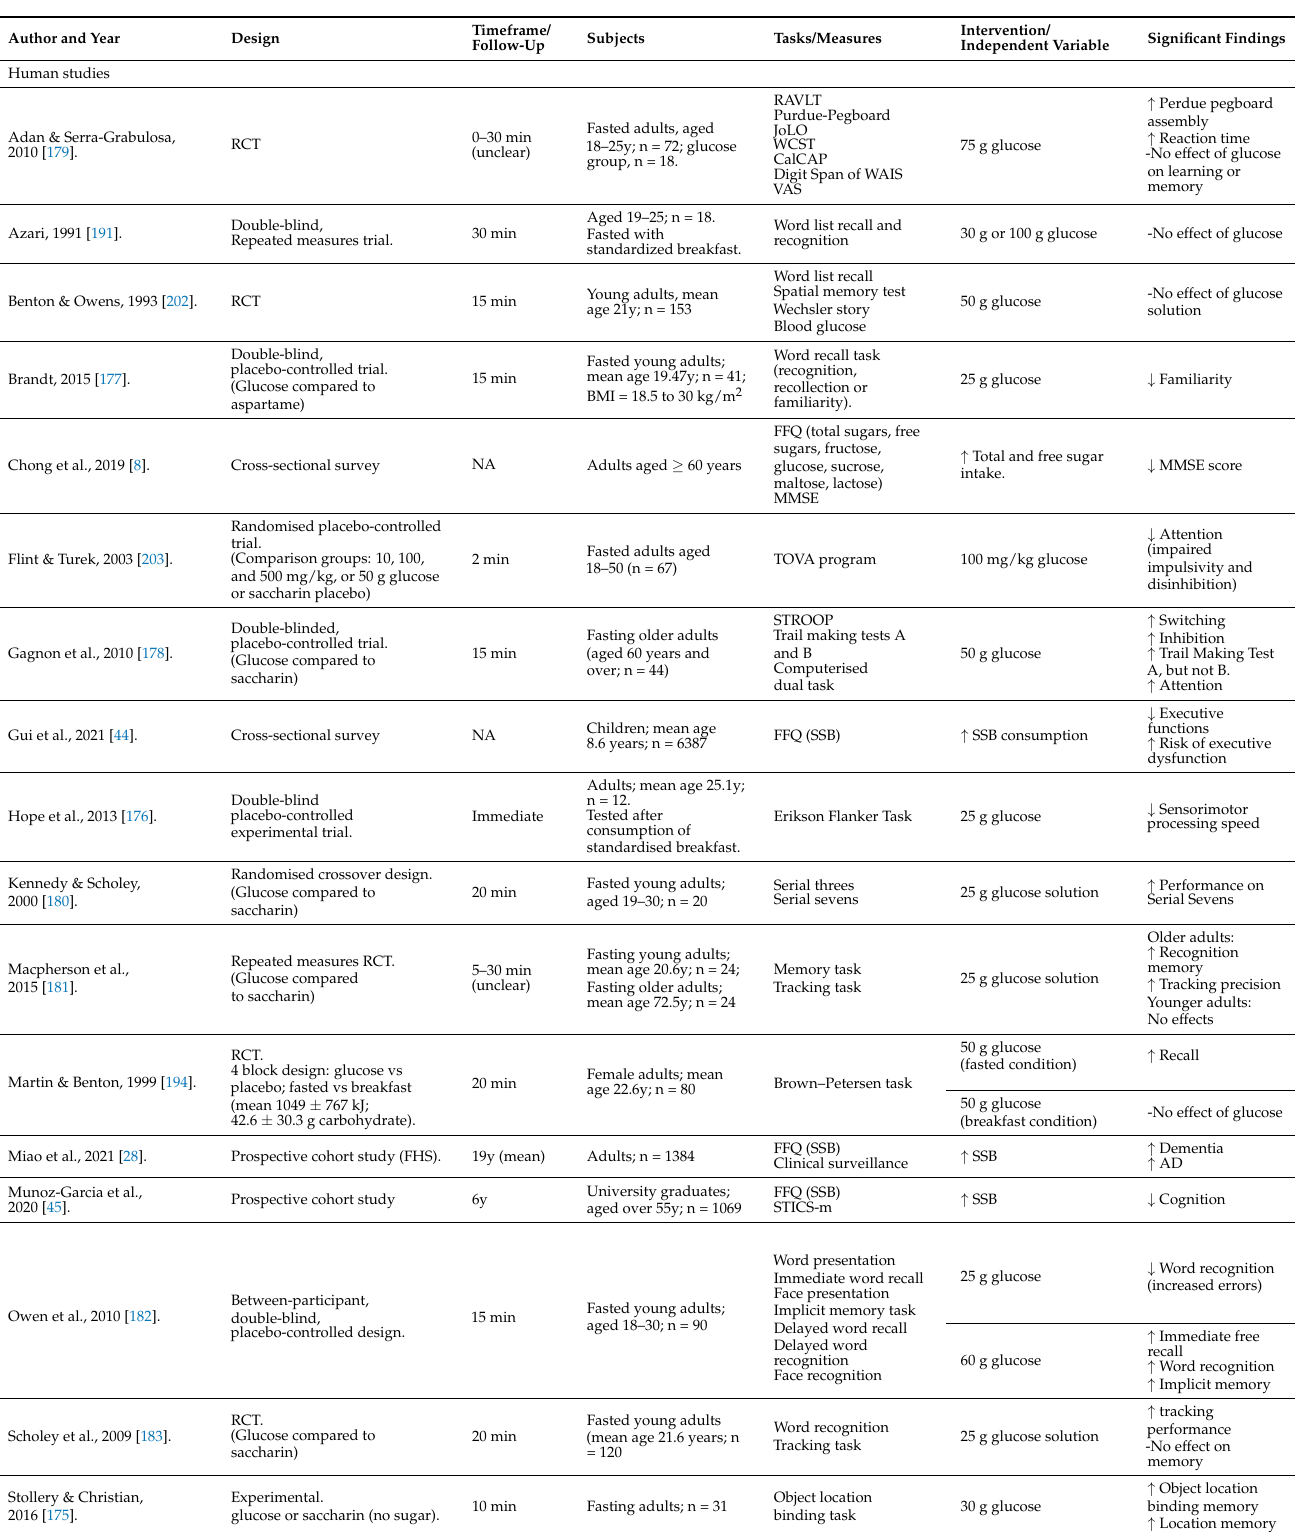
Table 3. Findings from published reports on the effects of free or added sugar consumption on cognition in healthy